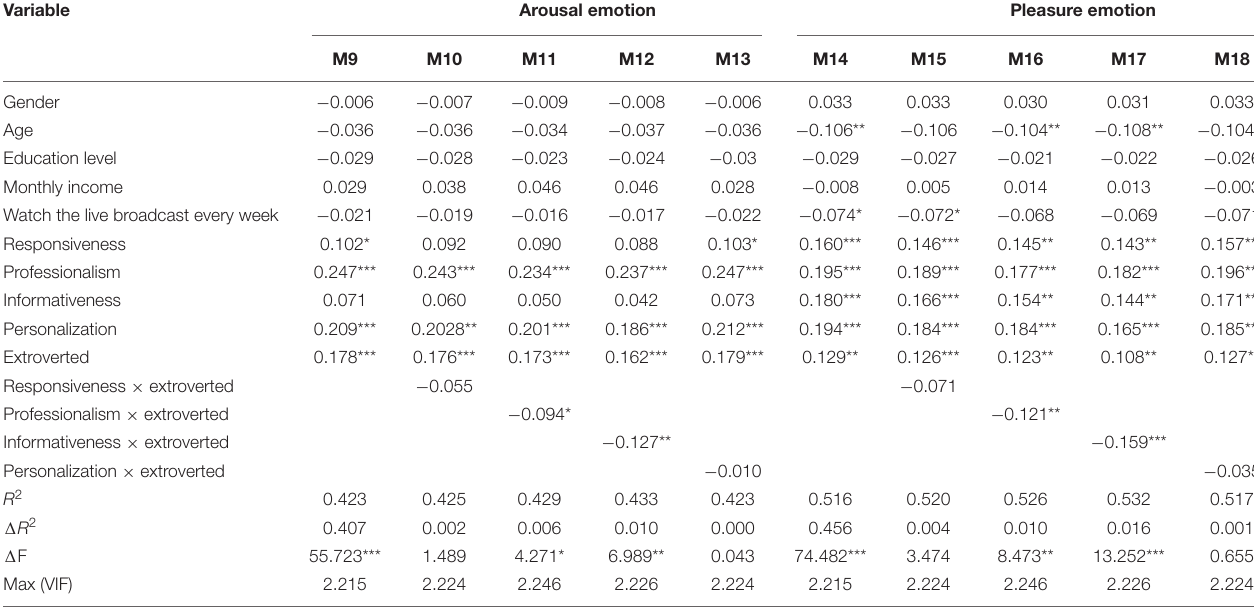
TABLE 5 | The moderating effect of extraversion personality